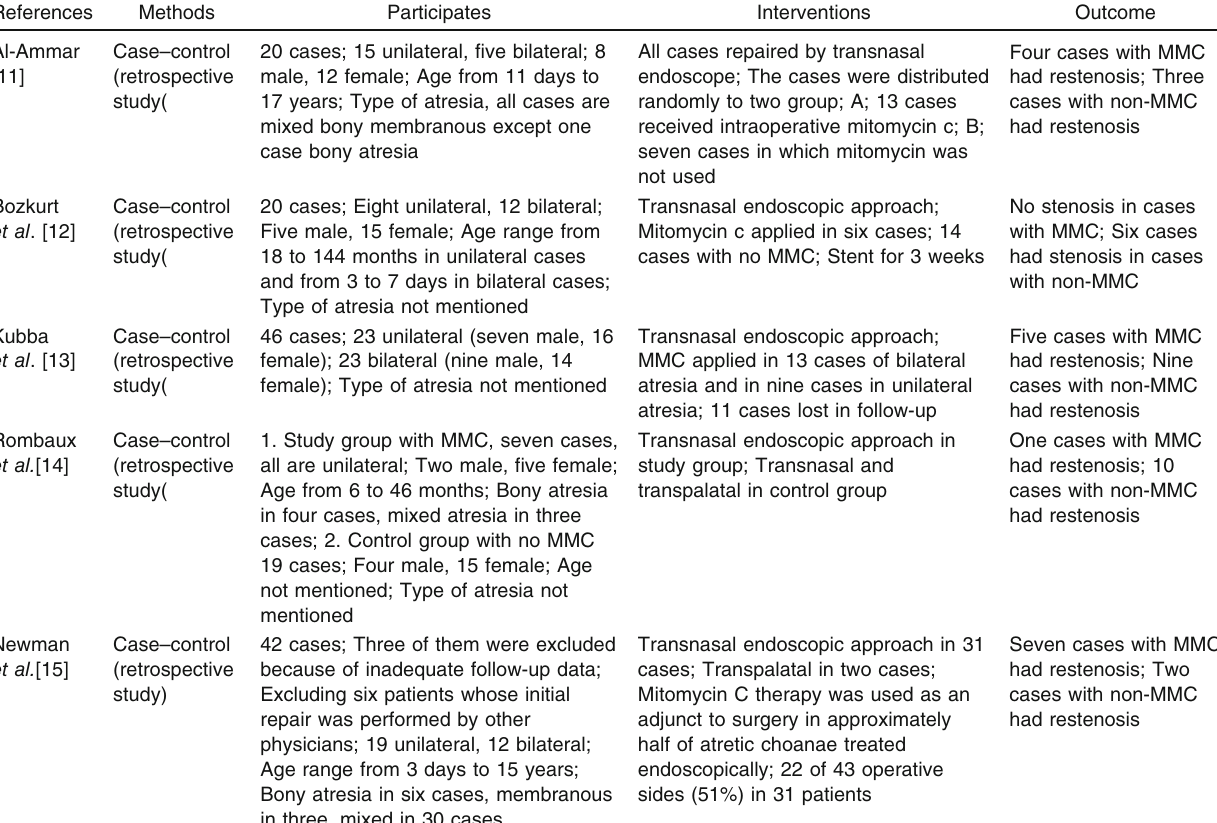
Table 5 Articles involved in studying the role of topical mitomycin c as adjuvant treatment to improve the outcome of repair of